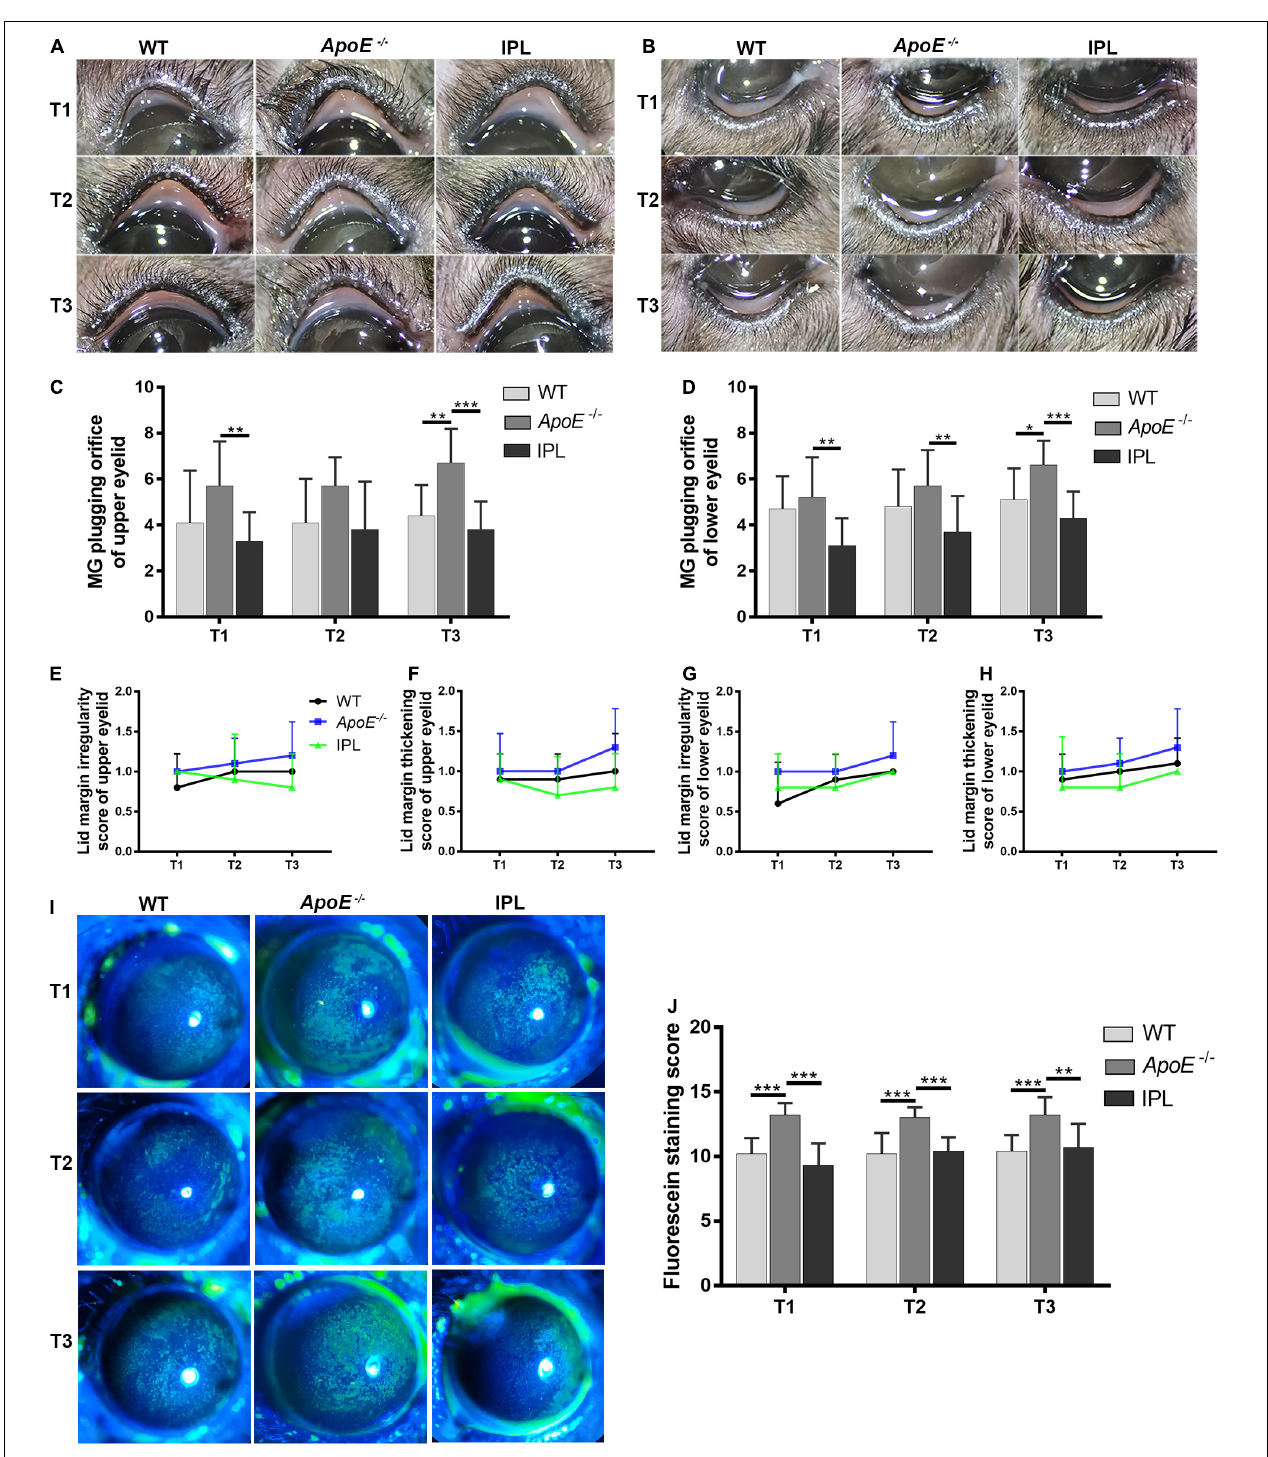
FIGURE 1 | Eyelid margin and ocular surface changes after IPL treatment. Representative macrophotographs of eyelid margins from the wild type group (WT), model group ( APOE − / − ), and IPL-treated group (IPL) showing MG orifices at the lid margins of the upper eyelids (A) and lower eyelids (B) at two weeks after the first (T1), second (T2) and third (T3) IPL treatments. Quantitative morphometric analysis of plugged MG orifices at the lid margin of the upper eyelids (C) and lower eyelids (D) ( n = 10/group). (E,F) Clinical score of lid margin irregularity and (G,H) lid margin thickening ( n = 10/group). (I) Representative fluorescein staining images and (J) staining scores ( n = 10/group). * p < 0.05, ** p < 0.01, *** p <